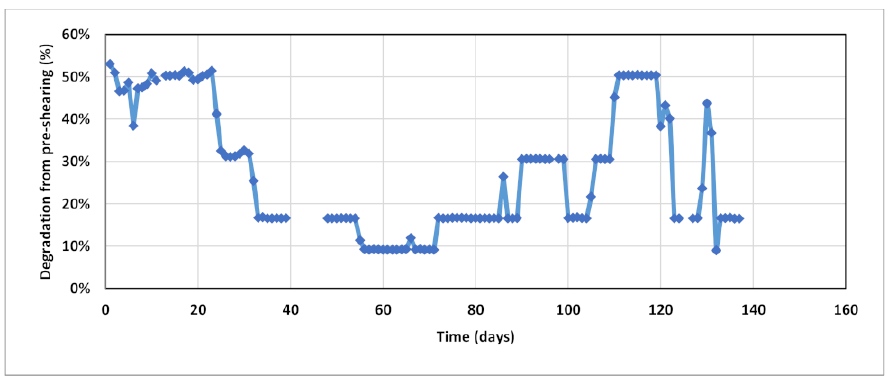
Figure 6. Percentage of degradation from pre-shearing applied on polymer solution prior to injection.